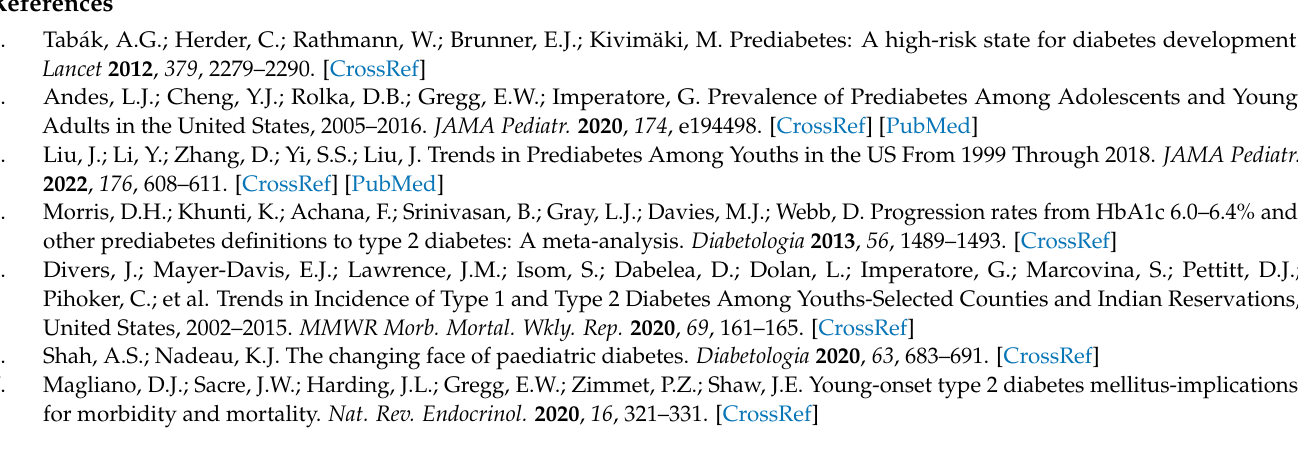
Table S1: Results (effects and 95% CIs) for sensitivity analyses at the baseline visit; Table S2: Results (effects and 95% CIs) for sensitivity analyses at the follow-up visit; Table S3: Results (effects and 95% CIs) for sensitivity analyses for the effects of change in diet score between visits; Table S4: Estimated effect size and 95% CI for the relationship between body composition and risk for prediabetes/type 2